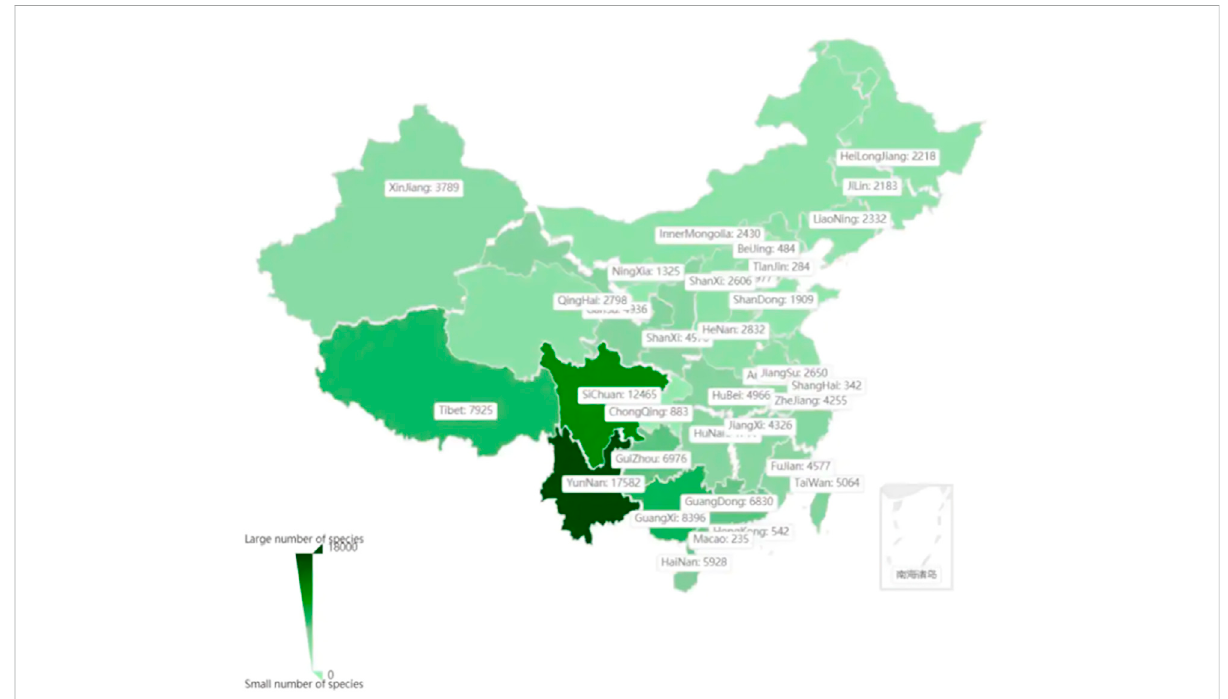
FIGURE 5 Distribution of plant species in various provincial administrative regions in China. The colour ranges from light to dark green to indicate the number of plant species from low to high. A darker colour refers to a more diversify plant species, while a lighter colour infers a smaller number of plant